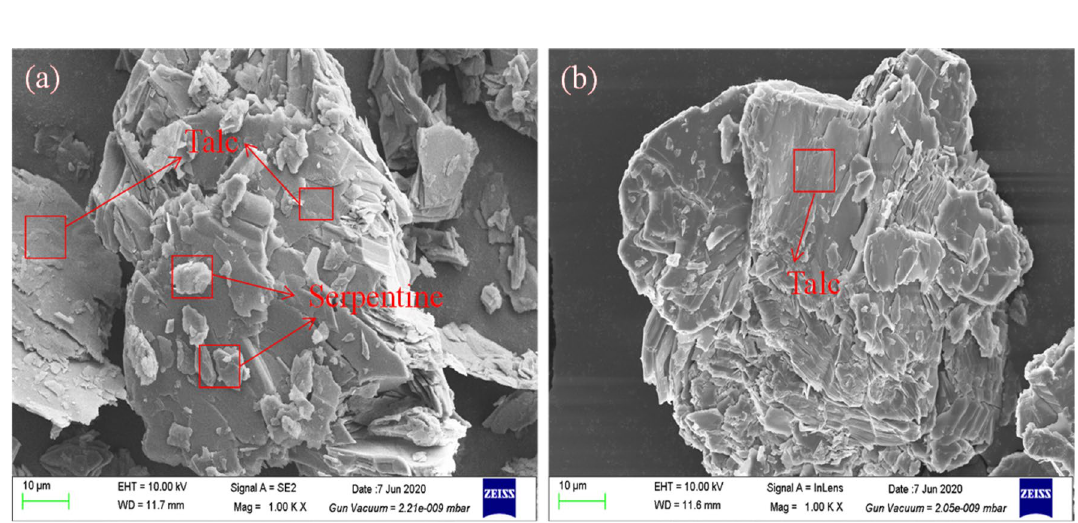
Figure 13. SEM analysis of mixed minerals of serpentine and talc: ( a ) mixed minerals of serpentine and talc; ( b ) mixed minerals of serpentine and talc with PAAS (PAAS = 24.7